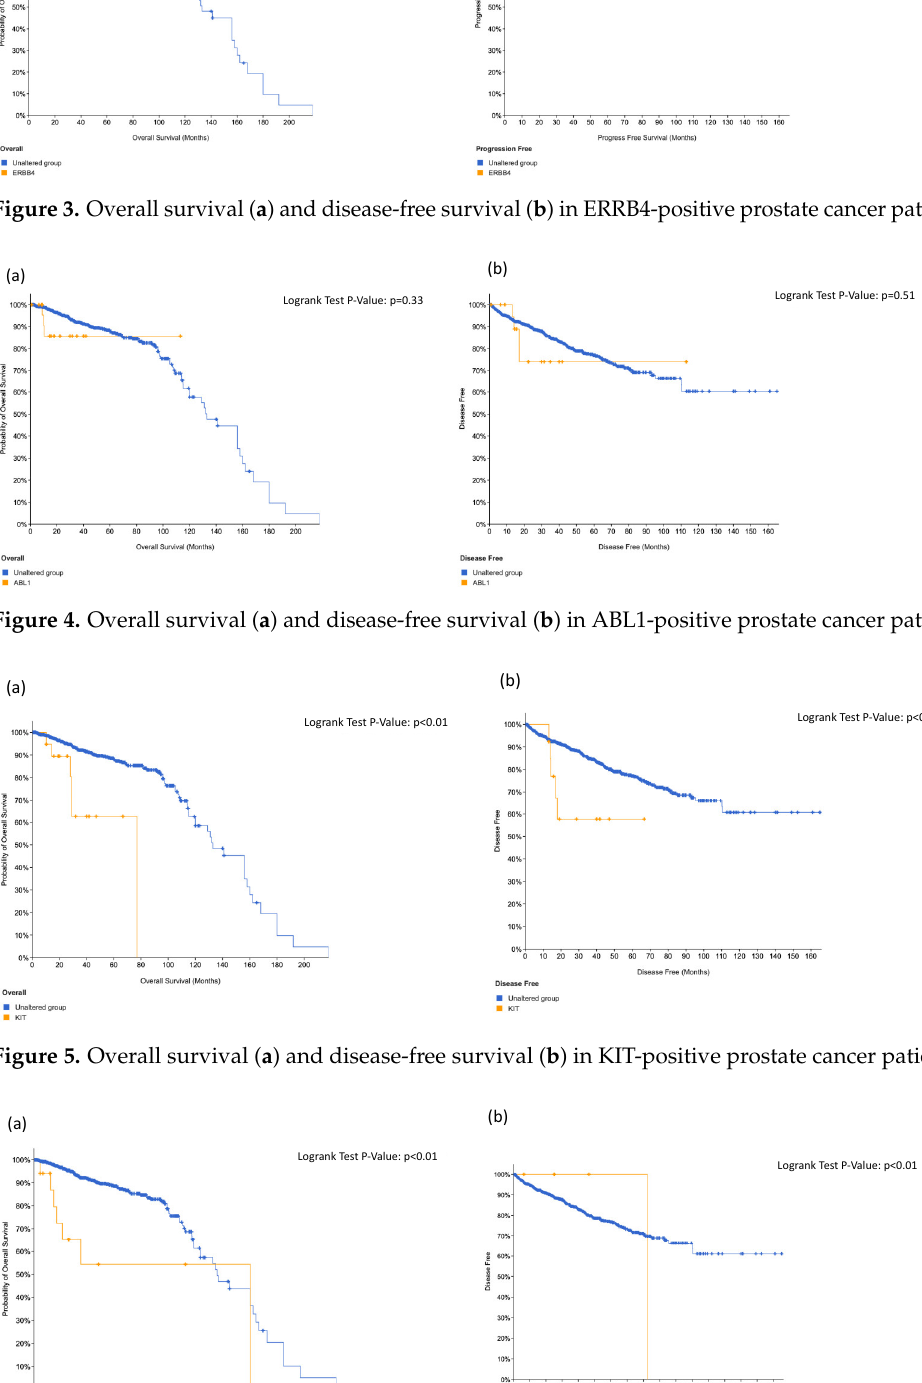
Figure 6. Overall survival ( a ) and disease-free survival ( b ) in HRAS-positive prostate cancer pa- tients.